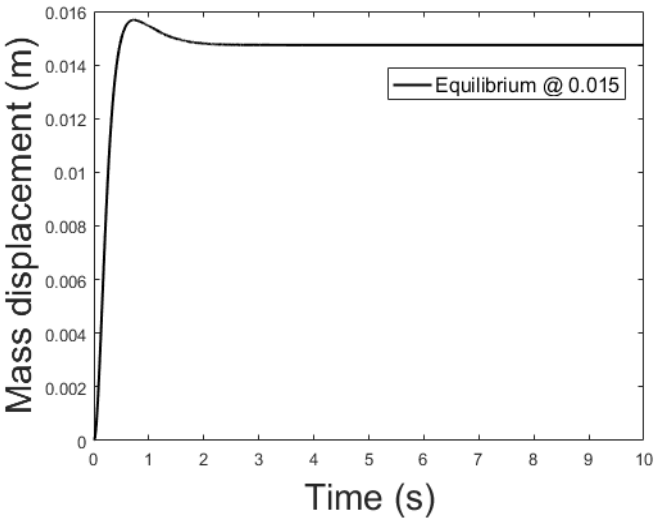
. x 0 = 0 m/s, ψ = 0 Wb and